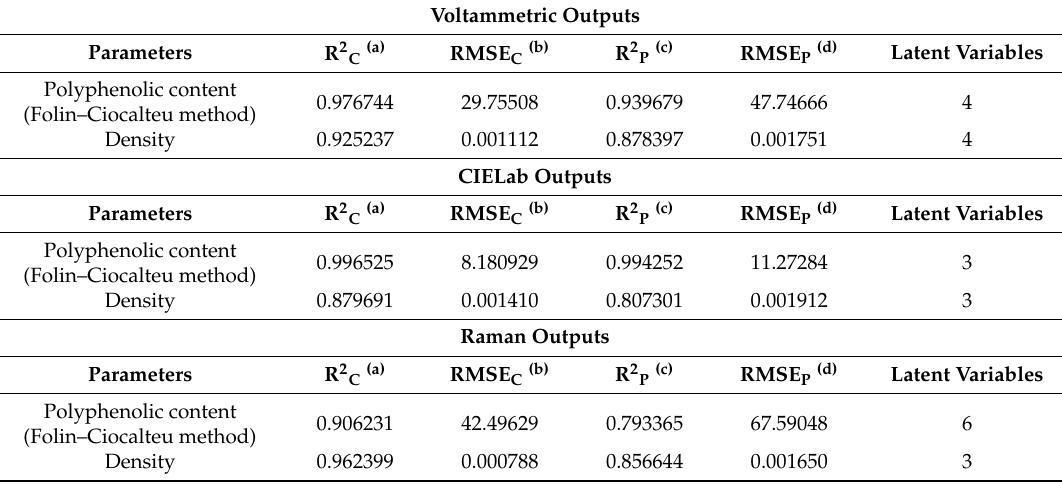
Table 4. Statistical parameters obtained for the PLS-1 regression model established between the chemical parameters and the voltammetric (e-tongue), CIELab and Raman responses towards nalewka